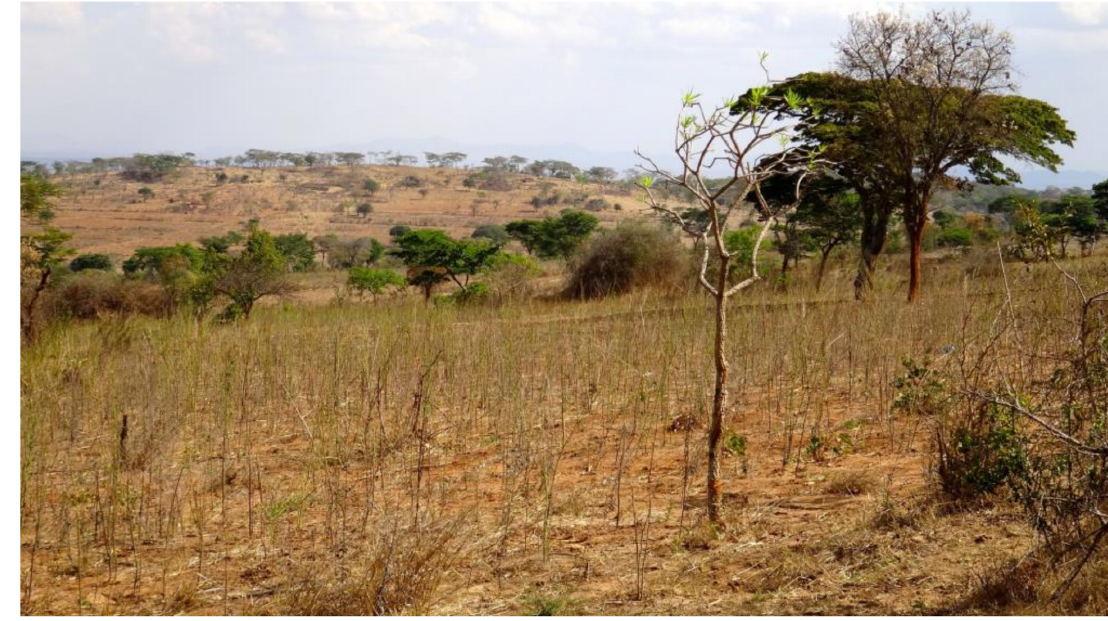
Figure 4. Newly opened fields in the Burunge